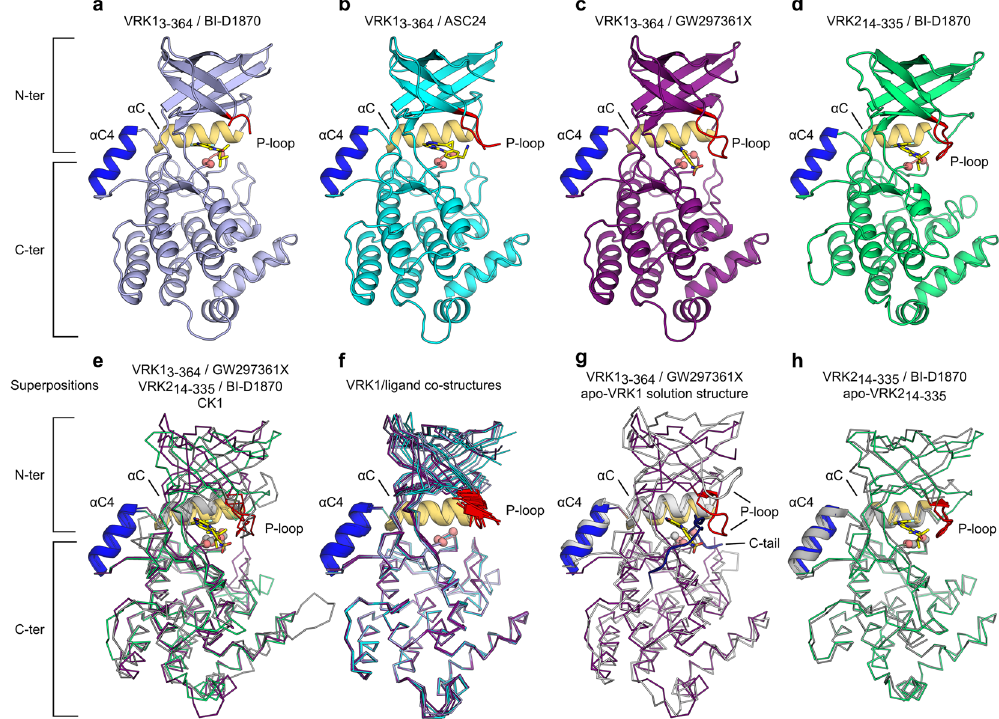
Figure 3. Co-crystal structures of ligand-bound active VRKs. Cartoon representation of VRK1 3-364 bound to ( a ) BI-D1870, ( b ) ASC24 and ( c ) GW297361X. ( d ) VRK2 14-335 in complex with BI-D1870. Positions of α C (in yellow), DYG motif (C α s shown as salmon spheres), α C4 (in blue) and P-loop (in red) are indicated. ( e